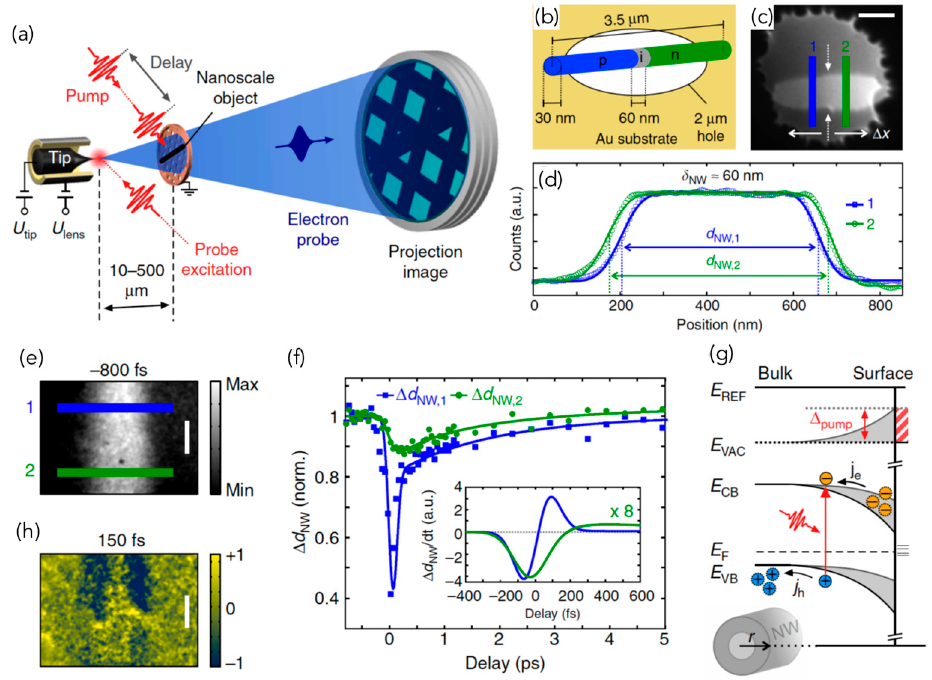
Figure 22. Setup for time-resolved low-energy electron point projection mode (PPM). ( a ) PPM operating principle: photoelectrons, generated from a nanotip by an ultrashort laser pulse, are accelerated towards the sample positioned several µm away from the tip. A pump laser pulse, variably delayed from the electron probe, photoexcites the sample. An electrostatic lens is used to switch between divergent and collimated (not shown here) diffraction modes. ( b – d ) Point projection microscopy of axially doped NWs. InP NWs (radius 15 nm, length 3.5 mm) with p-i-n axial doping profile and 60-nm i-segment in the center are spanned across 2-µm holes in a gold substrate. Instead of being a real shadow image of the objects shape, projection images are strongly influenced by local fields surrounding the NW. In addition, a spatial inhomogeneity (marked by the white arrows in ( c ) is observed ( d ). ( e – g ) Femtosecond imaging of ultrafast photocurrents. ( e ) Projection image of the same NW as in panel ( b ) recorded in pulsed fs-PPM mode at negative t . Photoexcitation by an ultrashort laser pulse leads to a transient, spatially inhomogeneous change of the projected NW diameter (h, normalized difference plot). Data recorded at 70 eV electron energy; scale bars: 500 nm. Different dynamical behavior and amplitudes of the transient diameter change Δ d NW are observed for the p- and n-doped segments along the NW ( f ), where an empirical three-exponential function was fitted to the data. Both segments show a fast initial photoinduced effect with 10–90 rise times in the p- and n-segments of 140 and 230 fs, respectively, followed by multi-exponential decay on the fs- to-few picosecond time scale. As Δ d NW is directly proportional to the transient electric field change, the derivative Δ d NW /dt plotted in the inset in ( f ) is a direct measure of the instantaneous photocurrent inside the NW. Surface states cause effective radial doping leading to band bending at the NW surface as sketched in ( g ), where r is the radial coordinate, causing a radial photocurrent of electrons, j e , and holes, j h , after photoexcitation. This leads to a pump-induced transient shift Δ pump of the energies of the conduction band edge (ECB) and valence band edge (EVB), and hence a shift of the vacuum level (E vac ) (red shaded area), compared to the reference level E ref (given by the environment), with the magnitude of the shift depending on the specific band bending and doping level. Figure adapted from Reference [259] with permission from Springer Nature. The advances in tip-based photoemitters and nanofabrication techniques have made it possible to achieve ps-resolution with ultrafast low-energy electron diffraction (ULEED) in backscattering mode. Storeck, Vogelgesang et al. [261,262] developed a novel µm-sized electron gun, which can be brought close to the investigated surface to diminish temporal broadening. The µm-sized electron source is presented in Figure 23 alongside ULEED results obtained in the study of 1T-TaS 2 . The